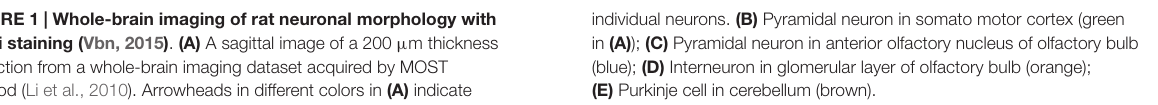
individual neurons. (B) Pyramidal neuron in somato motor cortex (green in (A) ); (C) Pyramidal neuron in anterior olfactory nucleus of olfactory bulb (blue); (D) Interneuron in glomerular layer of olfactory bulb (orange); (E) Purkinje cell in cerebellum